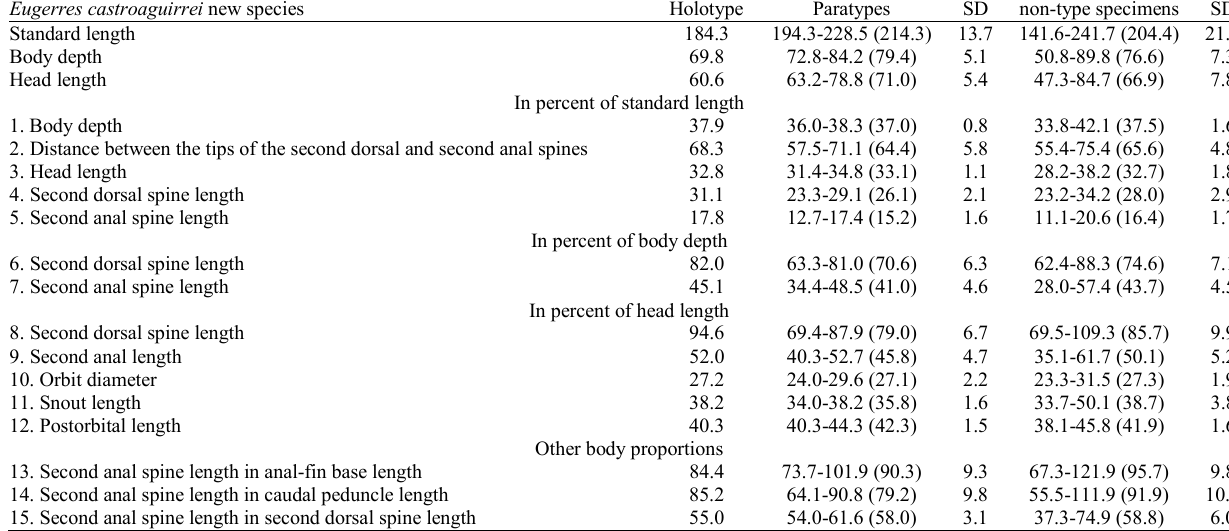
Table 1 . Morphometric data for Holotype, six Paratypes, and 35 non-type specimens of Eugerres castroaguirrei . Standard length, body depth and head length are expressed in millimeters. Numbers in parentheses: mean; SD: Standard